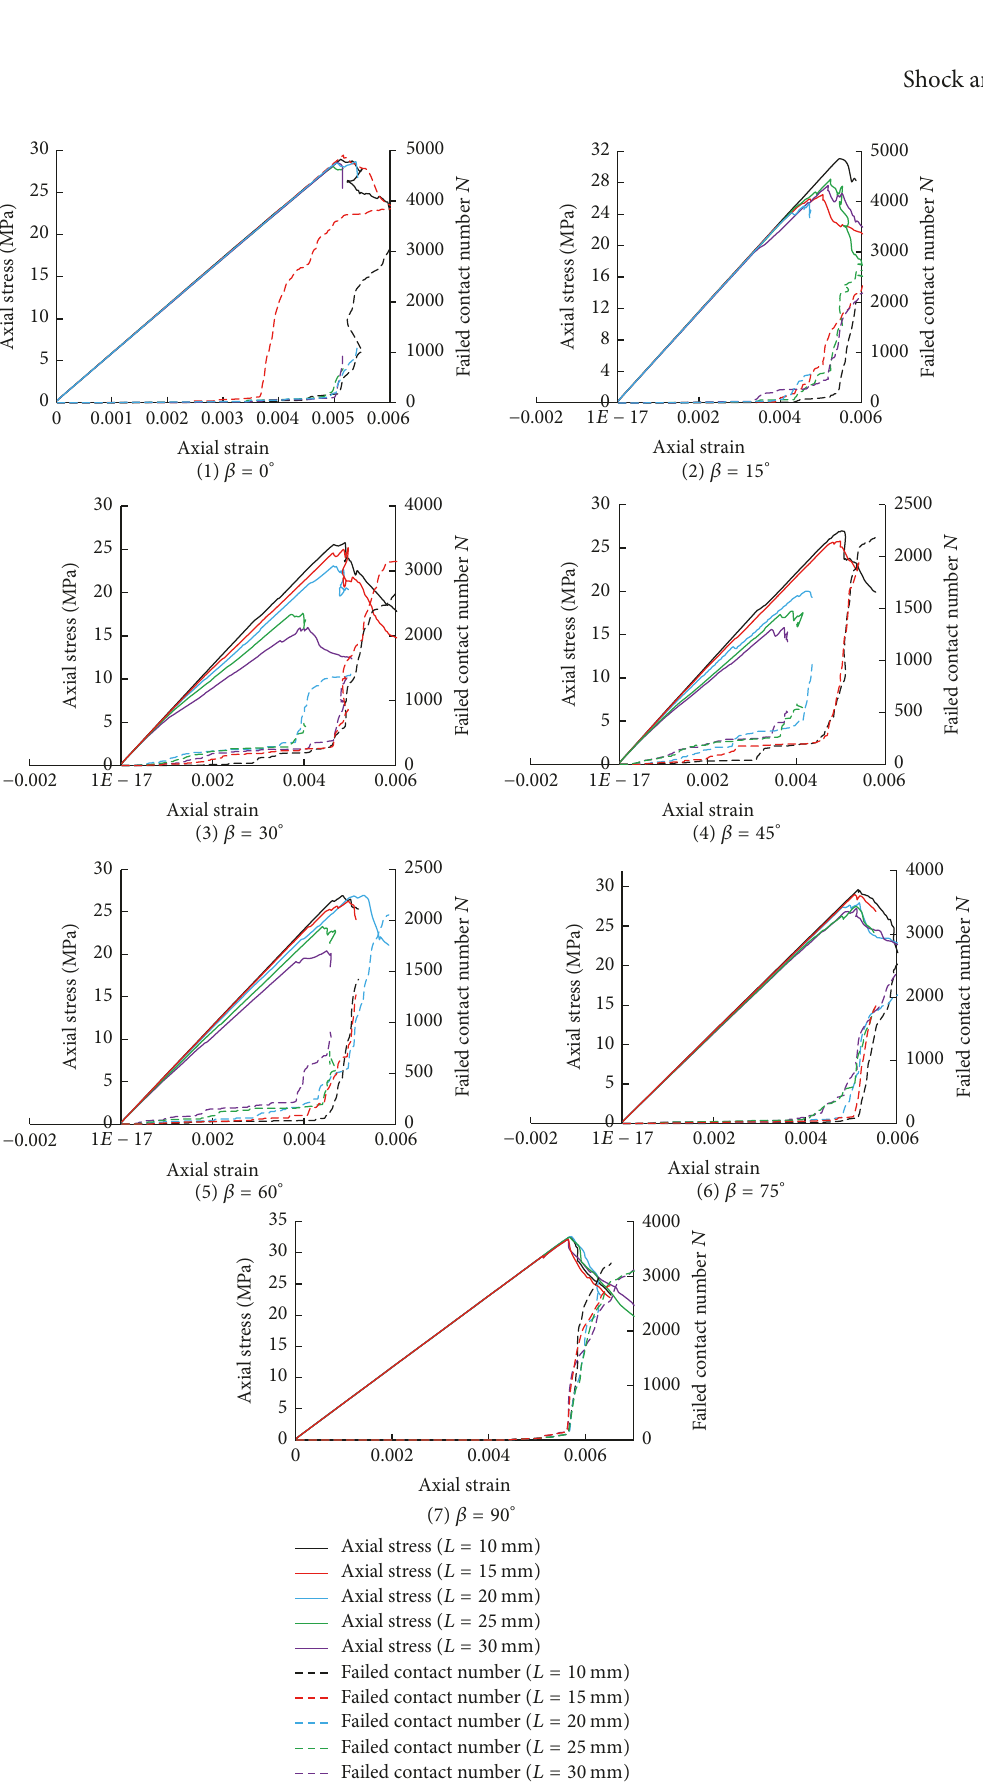
Figure 4: Axial stress-axial strain curves and contact number-axial strain curves for UDEC model containing a single flaw with different inclination angle and different length under uniaxial